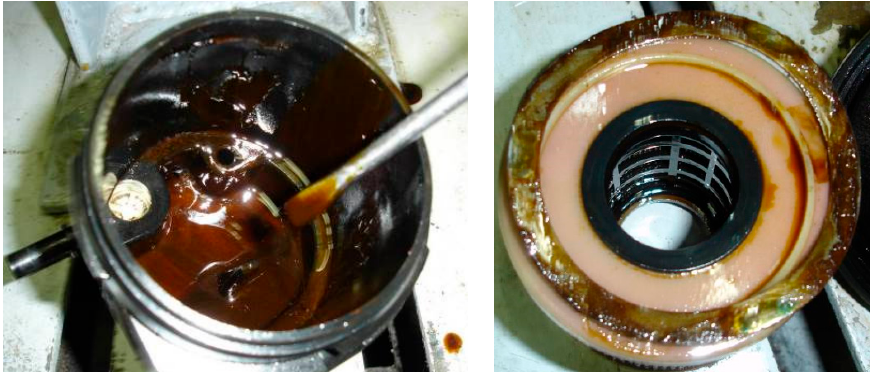
Figure 8. Fuel filter holder (left) and the filter cartridge (right) of the DW10 engine after 100 h operation with B70 and 50 h operation with B20 (see Table 7).